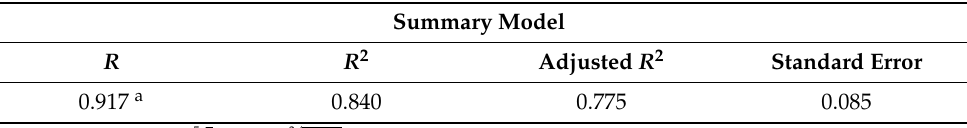
Table 13. Determination coefficients for strain model of CDWRCer.